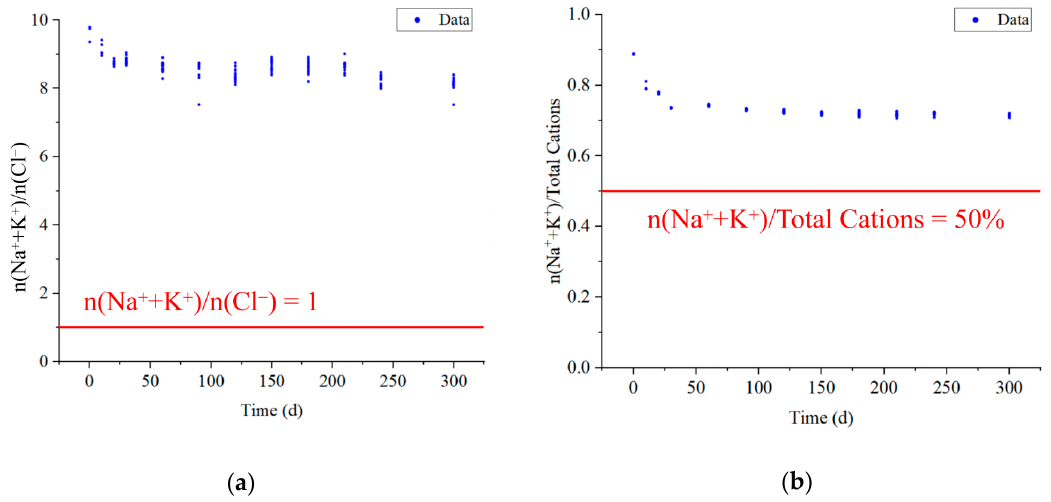
Figure 7. ( a ) Na + + K + versus Cl − and ( b ) Na + + K + versus total cations scatter diagram. Otherwise, the contribution of silicate dissolution to Na + and K + concentrations in groundwater can also be determined by the n(Na + + K + )/total cation concentration (TCC) values. If n(Na + + K + )/TCC > 50%, it indicates that Na+ and K+ groundwater is derived from silicate dissolution [40]. As shown in Figure 7b, n(Na + + K + )/TCC is much greater than 50% for all water samples, which indicates that the hydrolysis of silicate minerals is the main reason for the increase in Na + + K + concentration in the goaf water. Combined with the analysis of mineral content and change characteristics in Section 4.1, the hydrolysis occurs mainly in plagioclase (albite) and potassium feldspar of collapsed rock layers and medium sandstone, and the reaction Equations (1) and (2) [41]. Otherwise, the albite mineral weathering also increases the HCO 3 − concentration in goaf